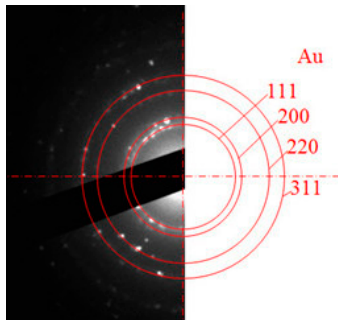
Figure 6. Selected area electron diffraction (SAED) pattern of sb-AuNPs in a 200 kV electron beam.